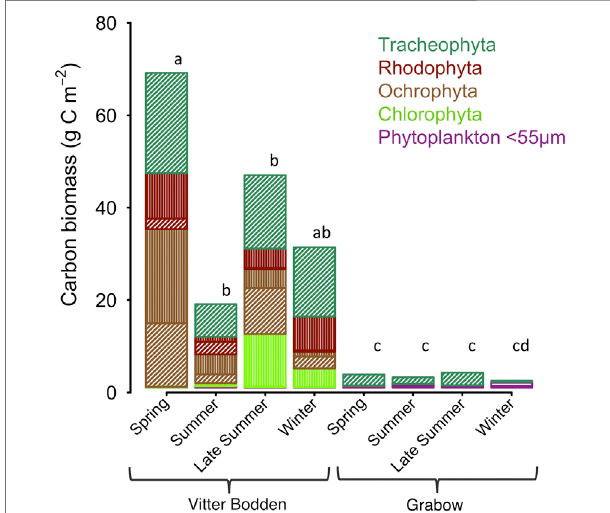
FIGURE 3 | Average biomass in carbon (g C m − 2 ) shown for each macrophytobenthic phylum in Vitter Bodden and Grabow. Filamentous macroalgal biomass is highlighted in vertical lines, non- fi lamentous macrophyte biomass in dashed lines, and phytoplankton in horizontal lines. Letters indicate signi fi cant differences between total biomasses (pairwise comparison, F (cid:2) 3.16, p < 0.05).